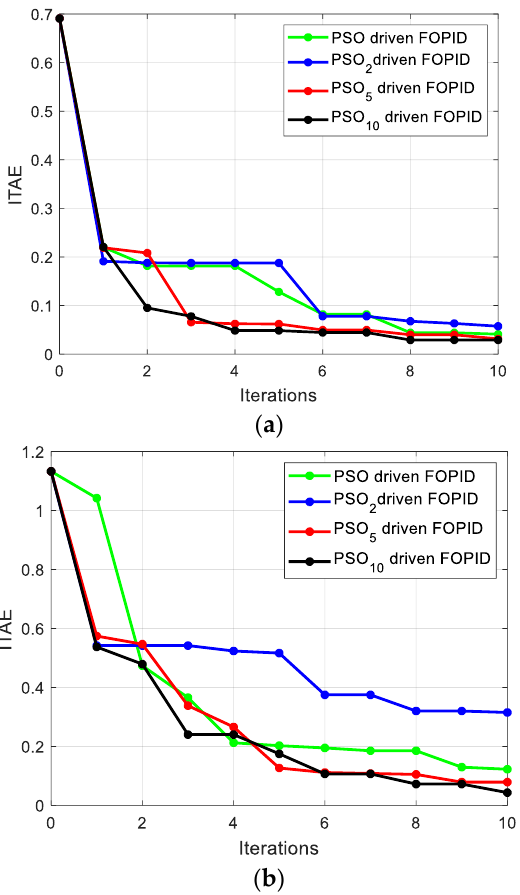
Figure 9. Comparative analysis of the proposed optimisation techniques in terms of convergence plots for ( a ) case study-I ( b ) case study-II.